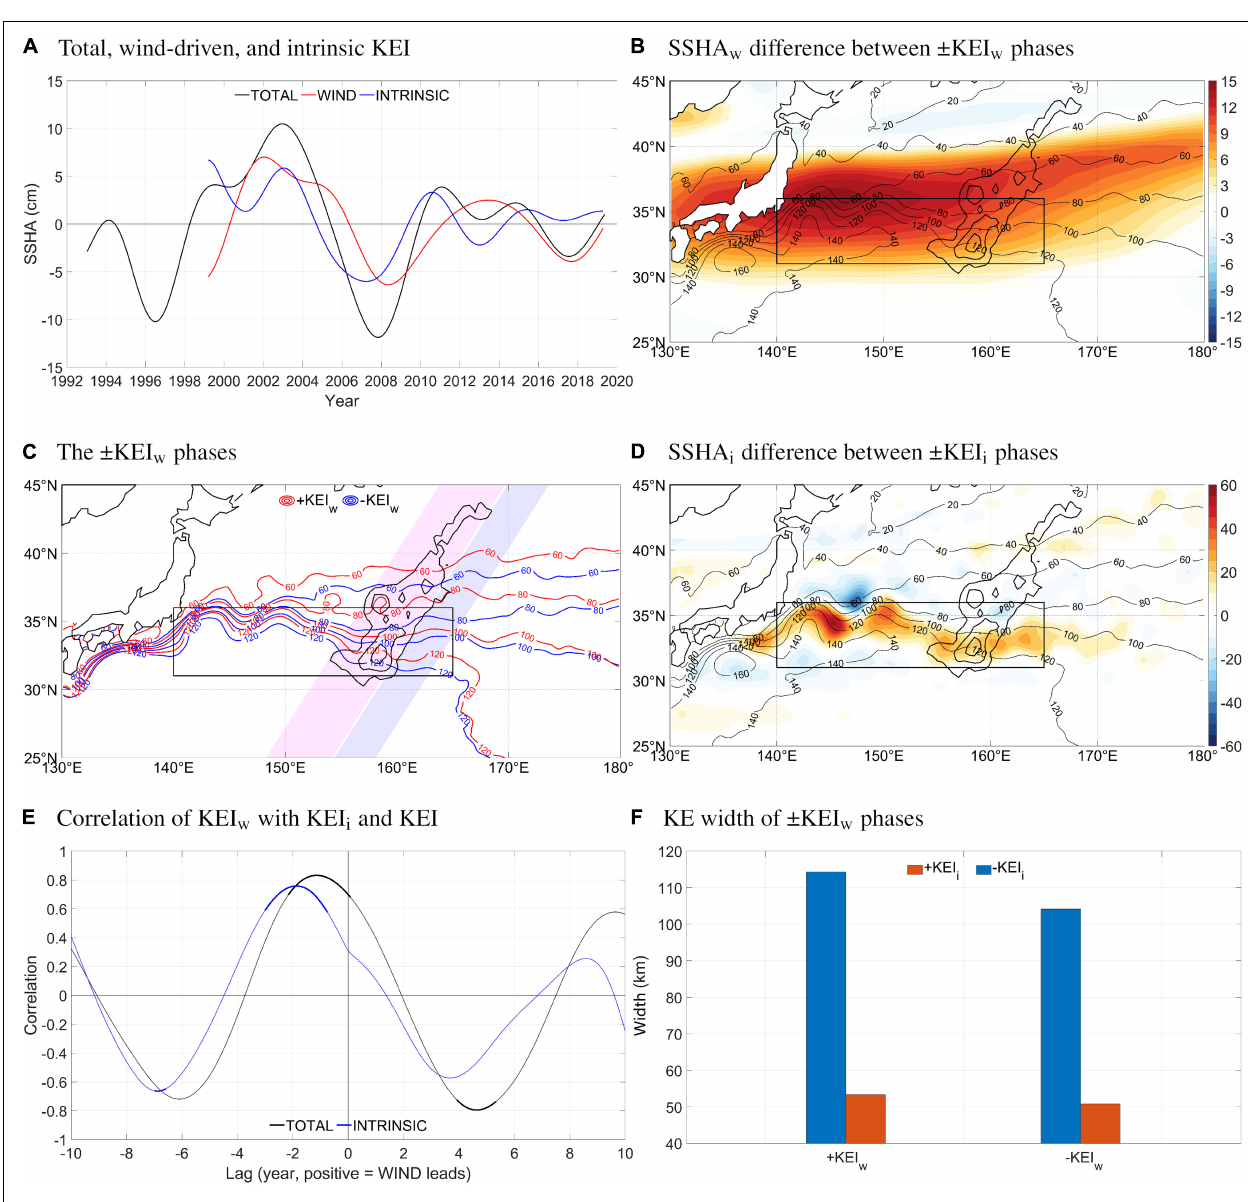
FIGURE 7 | (A) Time series of total KEI, KEI w , and KEI i . (B) SSHA difference (shading; cm) between the ± KEI w phases overlaid on time-mean SSH (thin contours; cm). (C) SSH (cm) of the ± KEI w phases. (D) as (B) , but for KEI i . Note the different color scales in (B,D) . (E) Correlation between KEI w -KEI (black) and KEI w -KEI i (blue). Thick curves denote statistical significance at the 95% level. The effective degrees of freedom are 2.6–4.4 (TOTAL) and 4.8–7.9 (INTRINSIC) depending on the lag. (F) Bar chart of meridional distance between 90 and 110 cm SSH contours when the ± KEI w phases are superimposed on the ± KEI i phases. In (B–D) , bathymetry of the Shatsky Rise is shown with the thick contours (CI = 1 km starting from 5